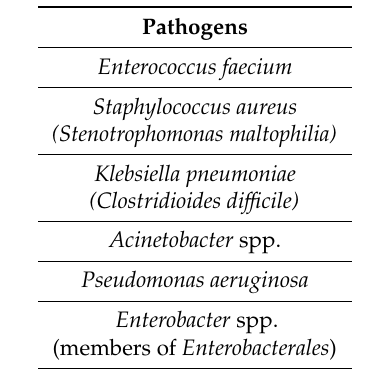
Table 2. Current list of ESKAPE